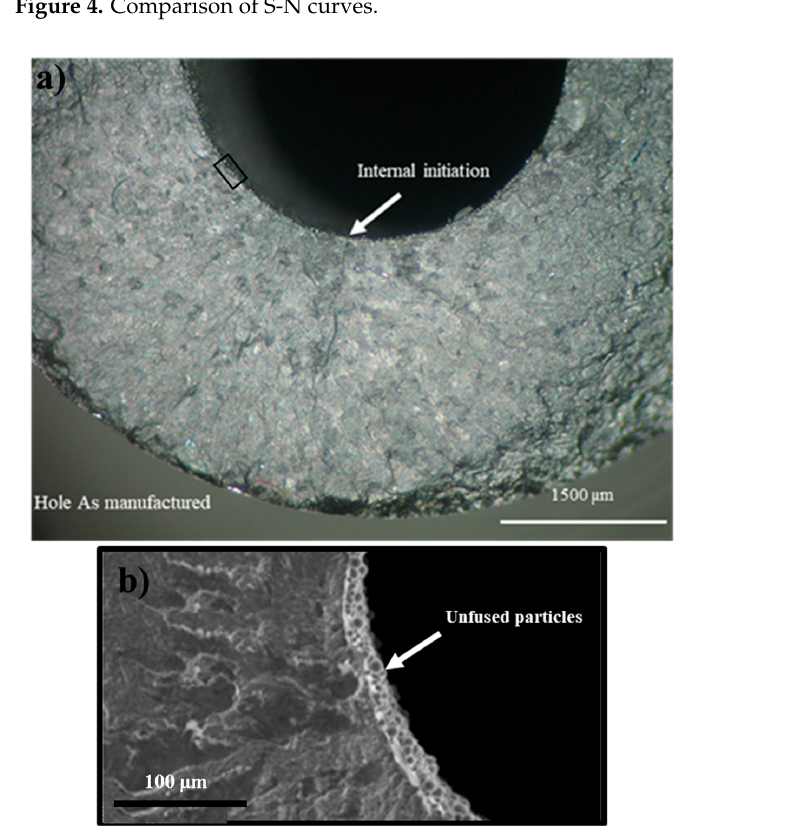
Figure 5. Fracture surface of hole as manufactured, σ a = 175 MPa. ( a ) Crack initiation; ( b ) Unfused particles.